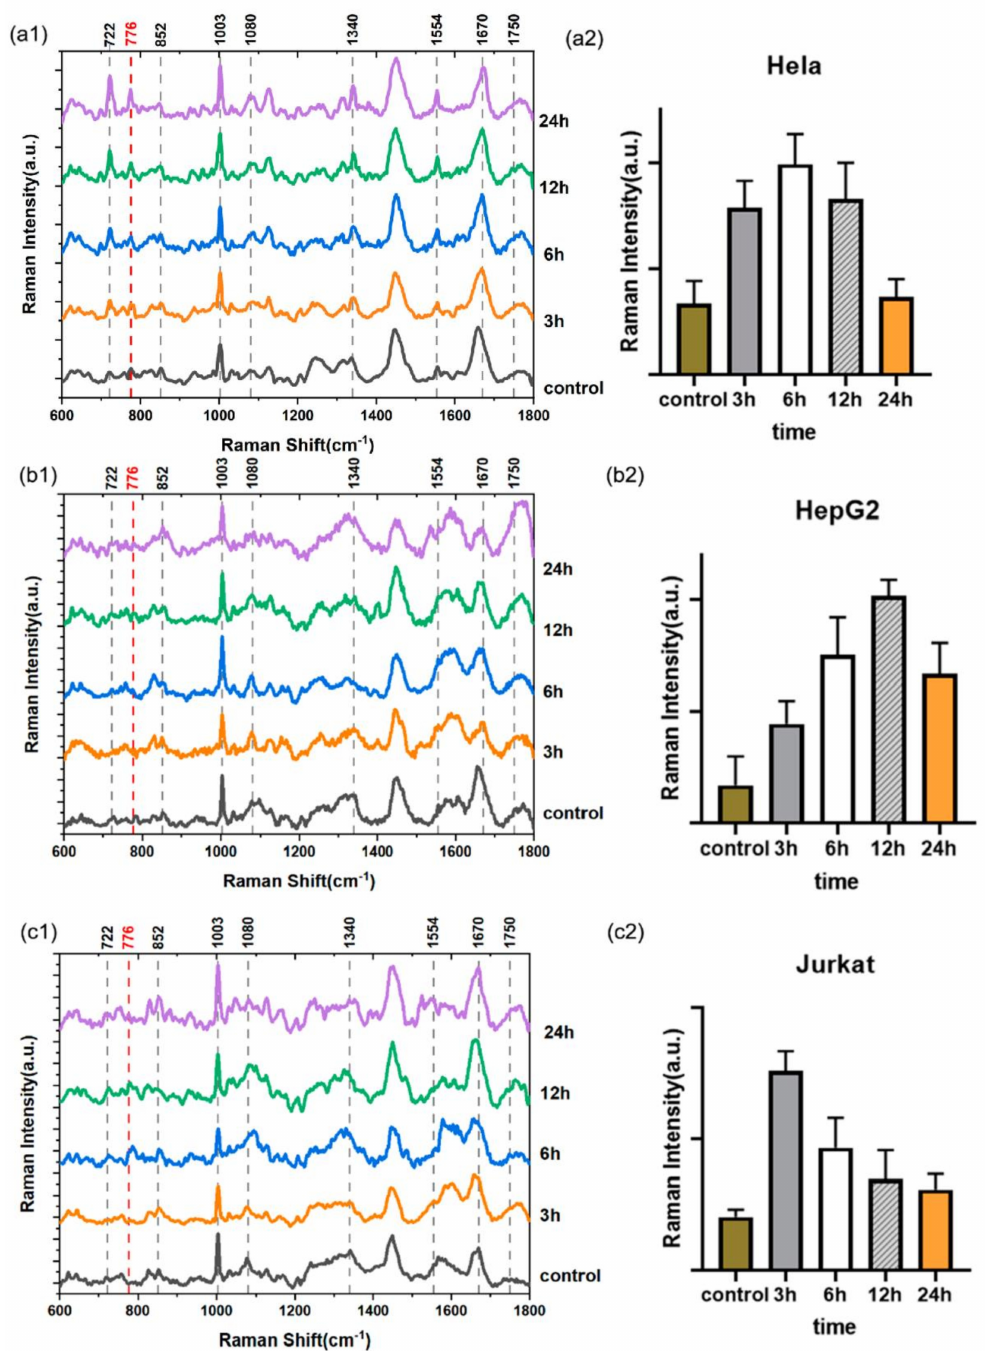
Figure 4. ( a1 – c1 ) Raman spectra of the three Rg3 − treated cell types over different lengths of time; ( a2 – c2 ) the normalized intensity of the peak at 776 cm − 1 versus